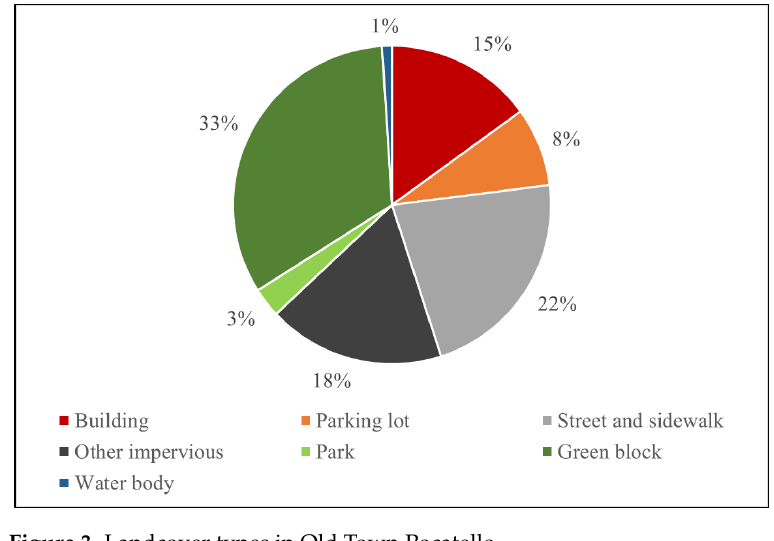
Figure 3. Landcover types in Old Town Pocatello.